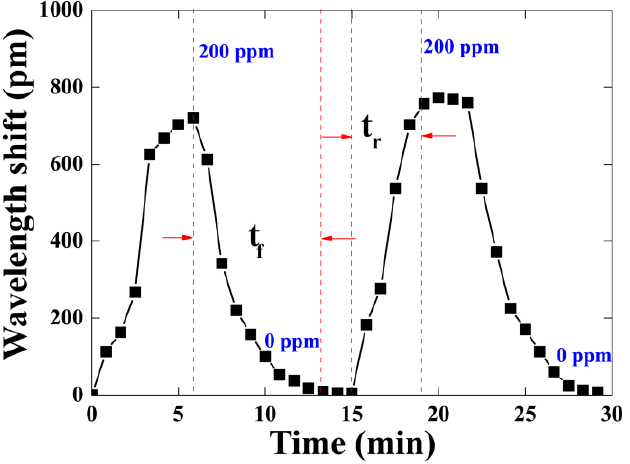
Figure 12. Dynamic responses of the sensor at the ammonia gas concentration of 200 ppm. spectrum changes, so we have tested the humidity response characteristics of the sensor. The sensor was put into a constant temperature and humidity chamber (J-TOPH-22-B,